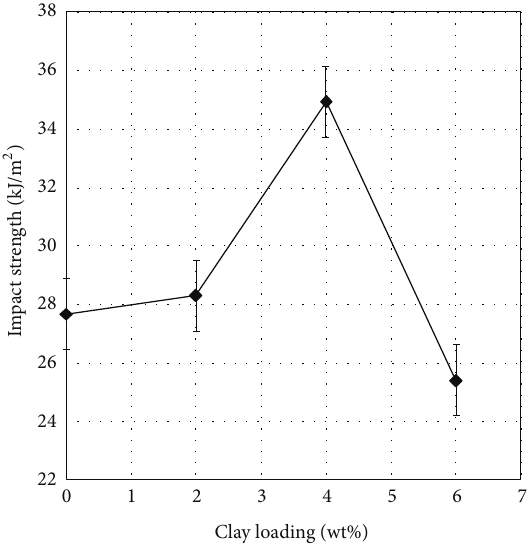
Figure 6: Effect of clay loading on the impact strength of UP/glass fiber/clay composites.